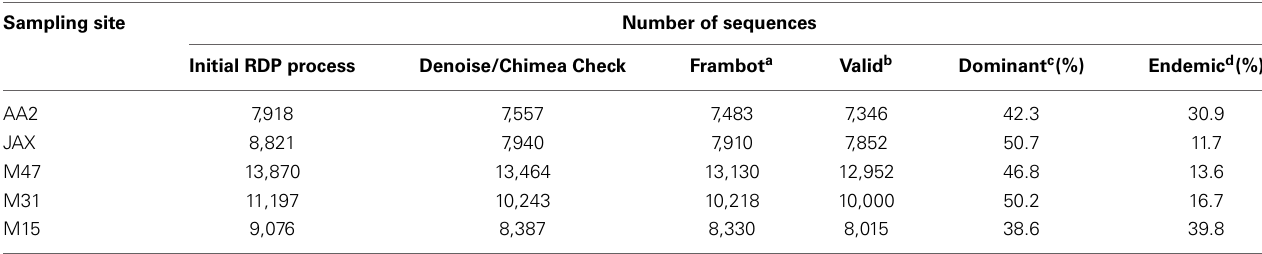
Table 3 | Number of nrfA sequences filtered during different steps of bioinformatic analysis.